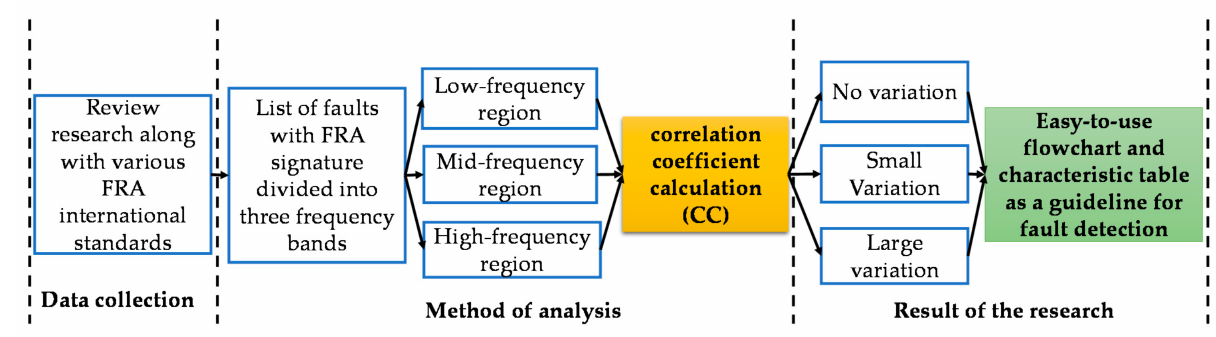
Figure 1. Steps and procedures of the proposed